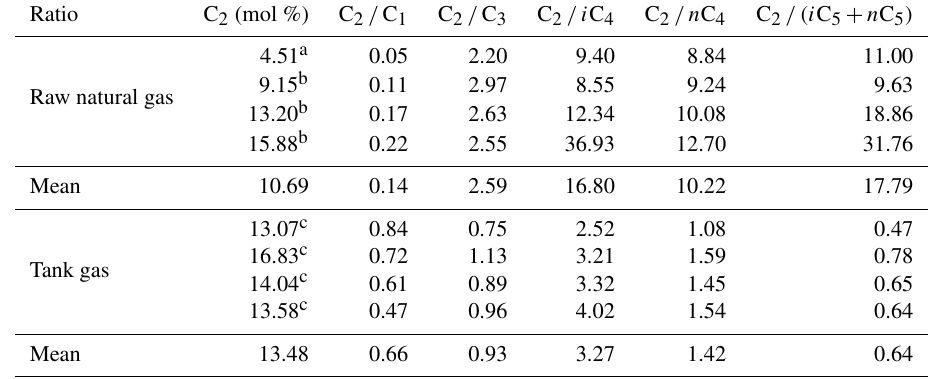
Table 2. Ethane content in raw natural gas and tank gas samples by mol percent and associated ethane / alkane ratios. Ratio C 2 (mol %) C 2 / C 1 C 2 / C 3 C 2 /i C 4 C 2 /n C 4